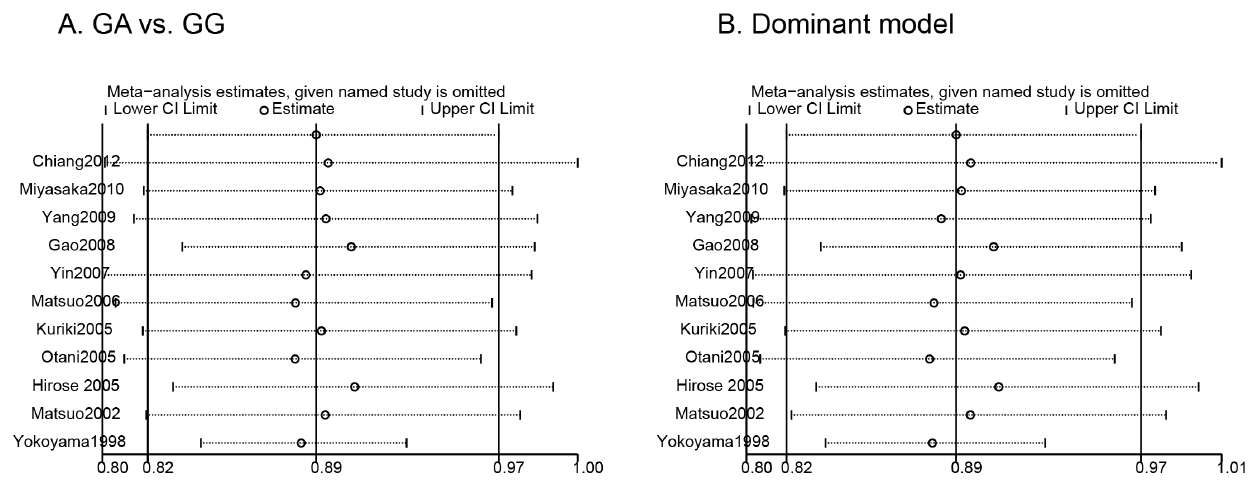
Figure 4. Influence analysis for ALDH2 Glu487Lys polymorphism in the overall analysis: A) GA vs. GG analysis; B) Dominant model analysis.